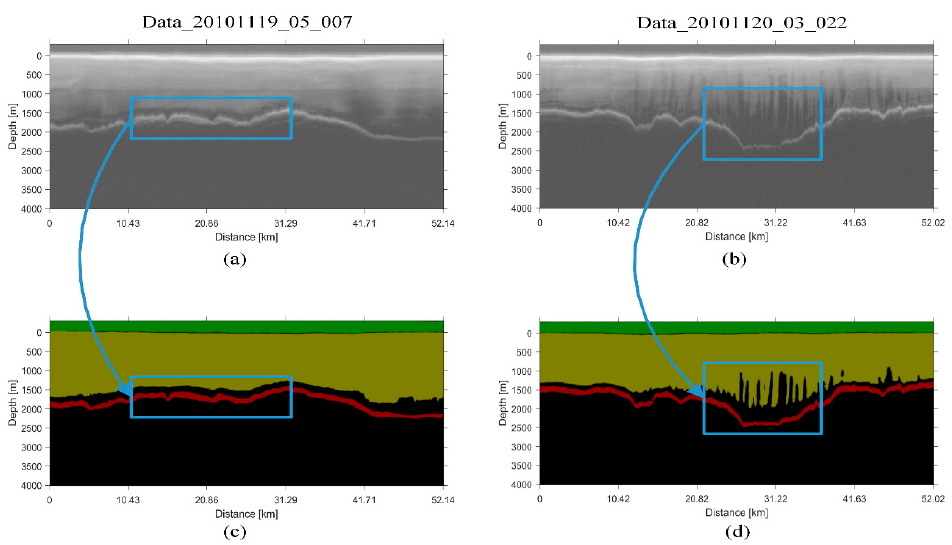
Figure 7. Examples of ( a , b ) radargrams and ( c , d ) corresponding classification maps generated with the presented network. In the classification maps, each class corresponds to a di ff erent color: free space (green); layers (yellow); bedrock (red); noise and EFZ